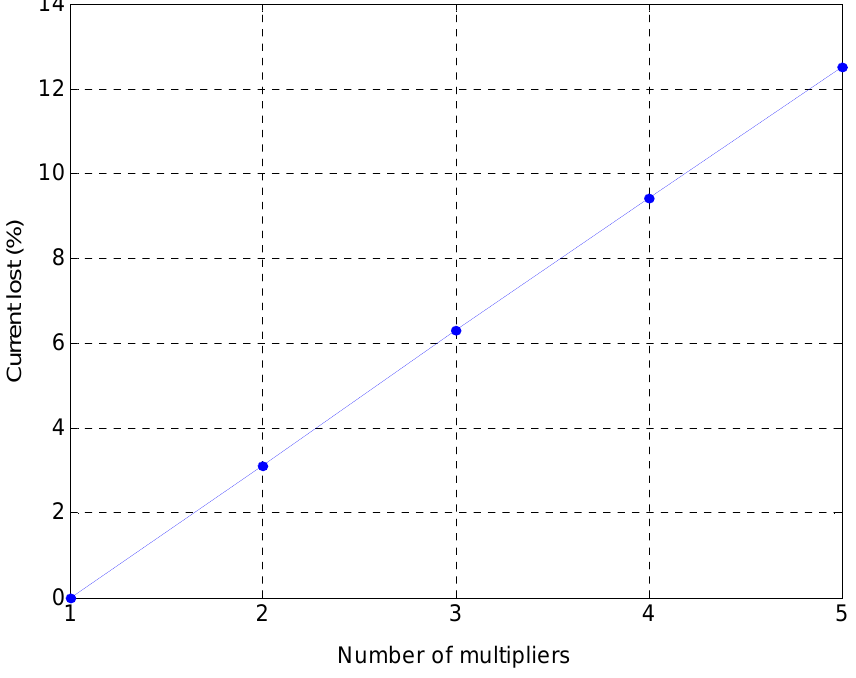
Figure 9. Current lost due to connecting several multipliers to a single logistic circuit